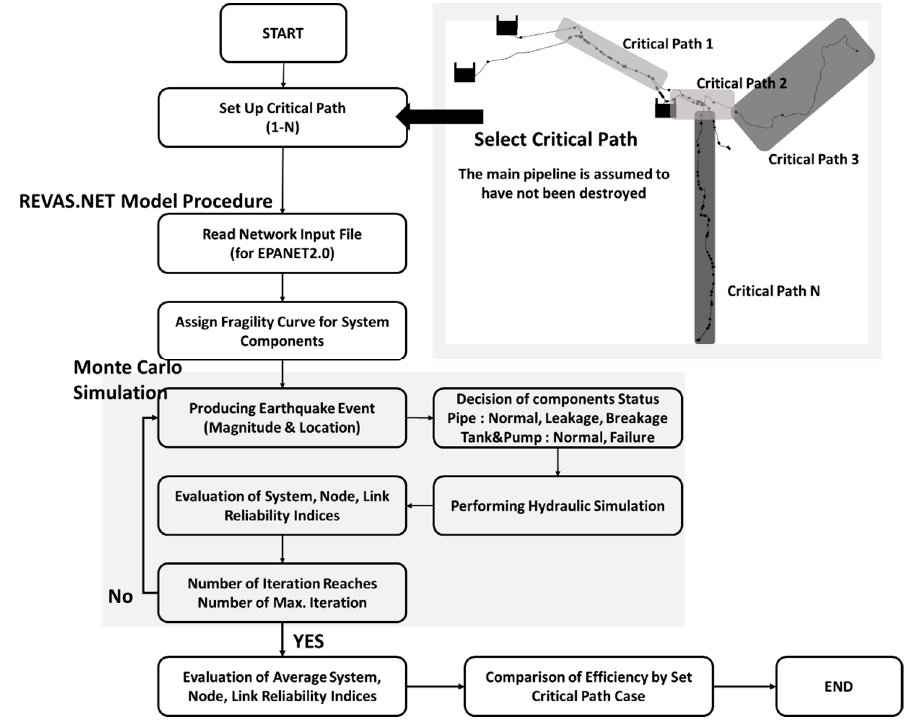
Figure 1. Schematic illustration of the research methodology. REVAS.NET: Reliability Evaluation model of Seismic hazard for water supply NETwork.